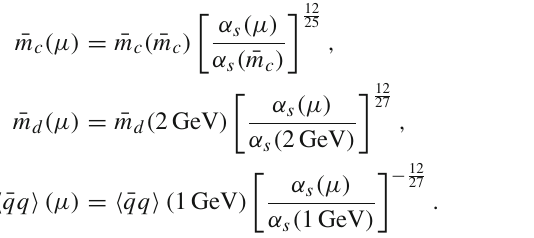
determining the Borel windows of the D -meson leading-twist DA moments (cid:3) ξ n (cid:4) D